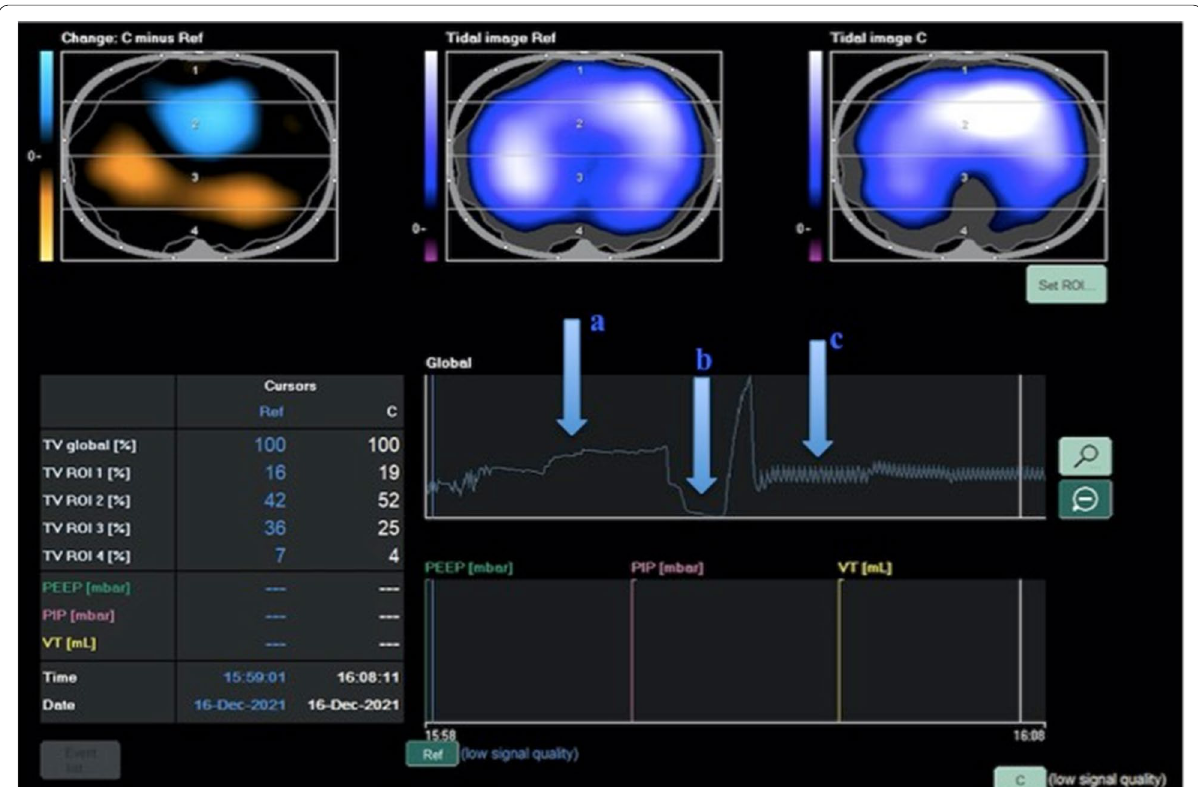
Fig. 2 From spontaneous breathing ( a ) to induction of anesthesia and ventilation in bag mask ( b ) and controlled mechanical ventilation, followed by the application of an external PEEP ( c